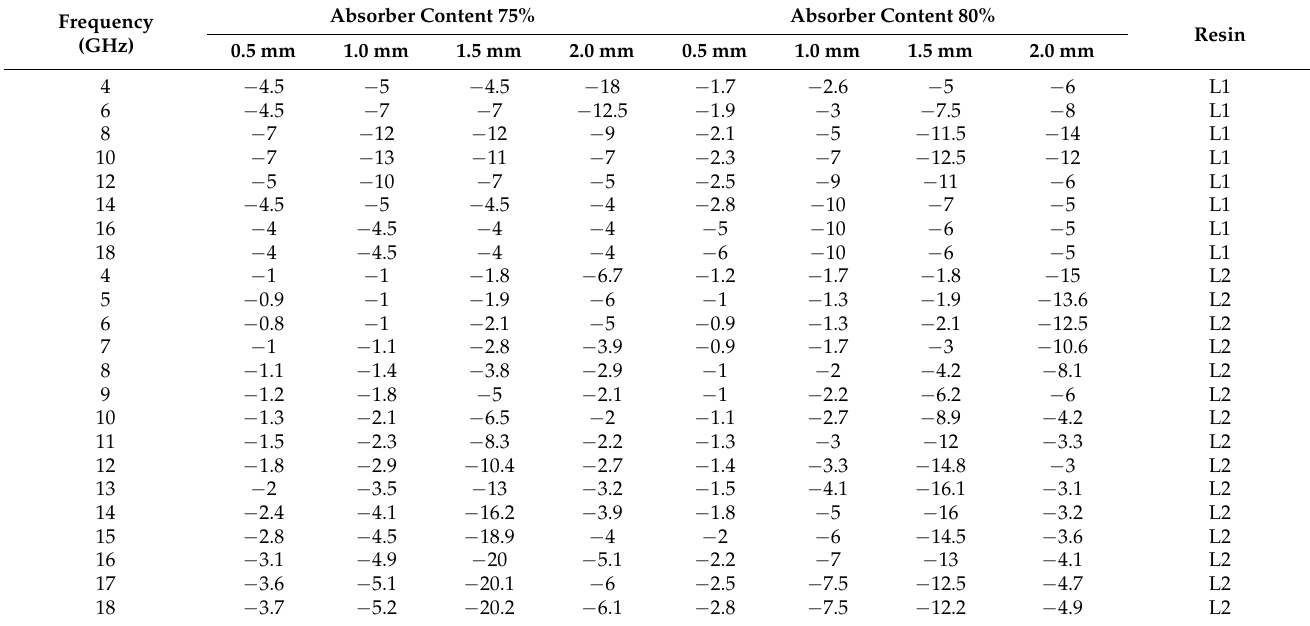
Table 3. Comprehensive list of attenuation values